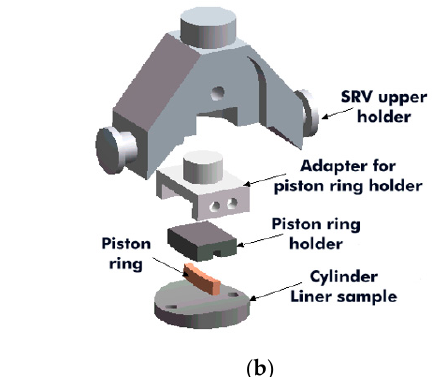
Tribological test assembly for cylinder liner samples, designed by TEKNIKER © to adapt to the SRV machine. Piston